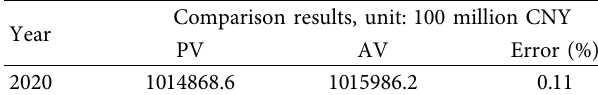
Table 3: ANN model prediction output